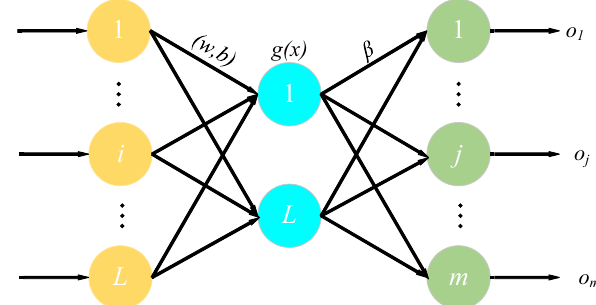
Figure 2: A general form of an ELM